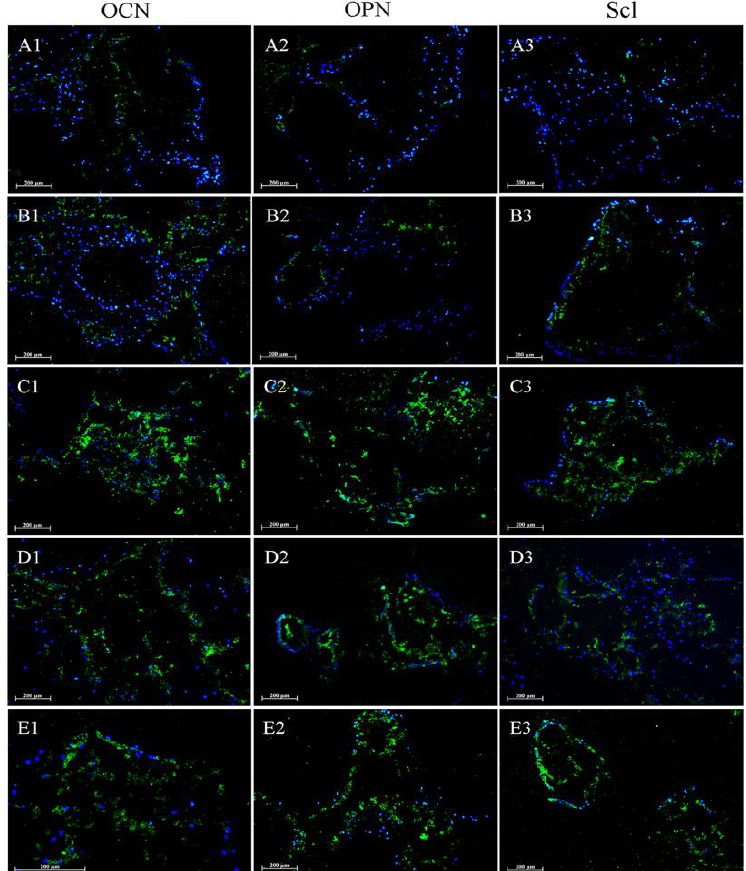
showed increased OCN, OPN and Scl expression compared to the MN and MO groups.